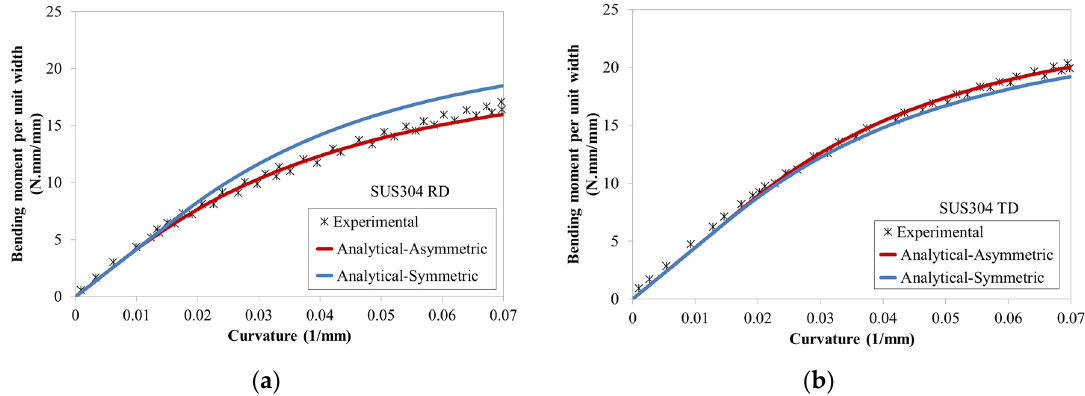
Figure 7. Comparison of bending moment–curvature diagrams for pure bending in the ( a ) rolling direction and ( b ) transverse direction.